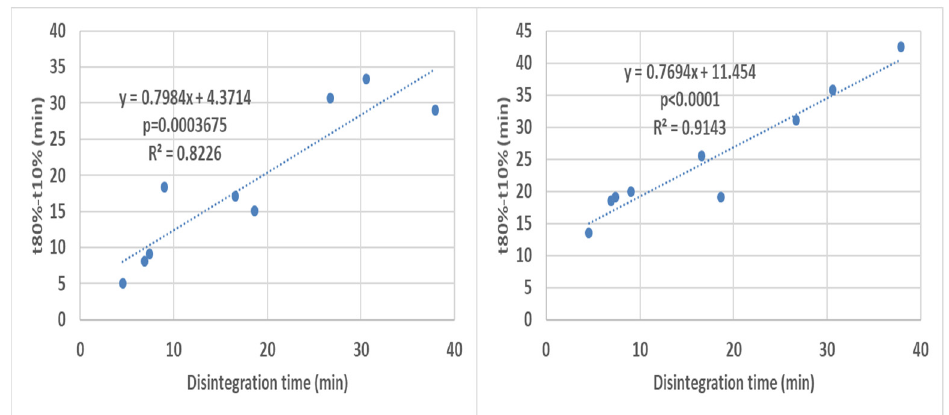
Figure 9. Overall correlation of all the disintegration times with their (t80%–t10%) values results (all formulations in all media are present in each graph) in the basket apparatus (right-hand side) and the paddle apparatus (left-hand-side) . The p -value is a one-sided value for a t -test applied to the slope.